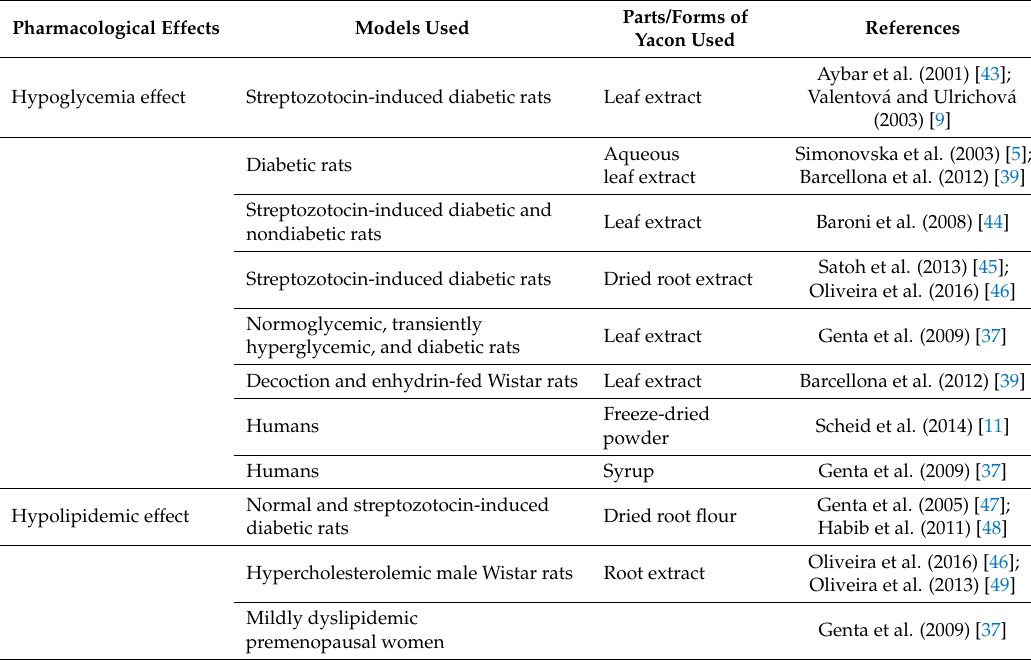
Table 3. An overview of major nutrigenomic properties of